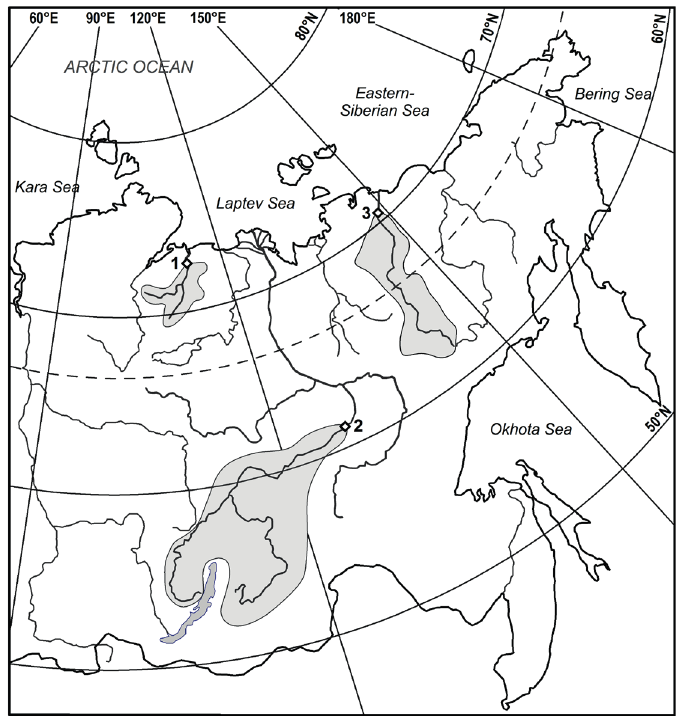
Fig. 1 Locations of the study gauging stations, showing their watersheds: the Anabar River at Saskylakh (1), the Lena River at Tabaga (2), and the Indigirka River at Vorontsovo (3).